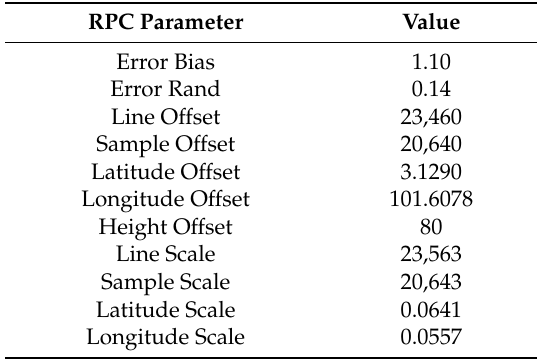
Table 2. Rational polynomial coefficients (RPC) specification of